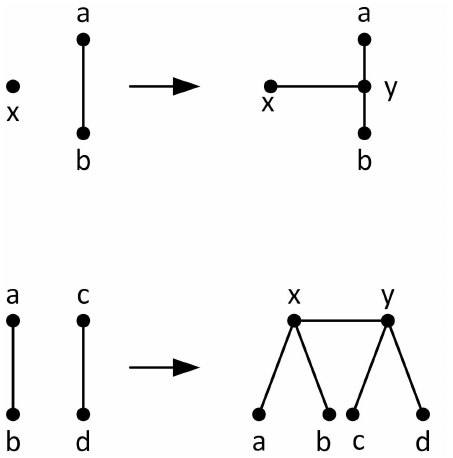
Figure 3. Bridging two edges and bridging a vertex and an